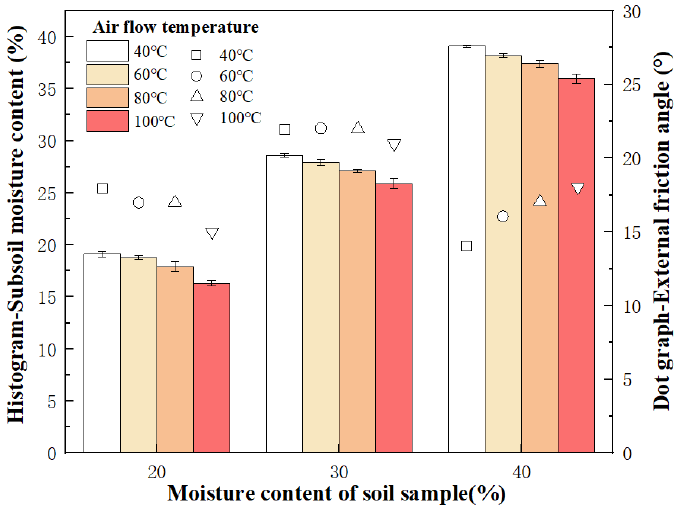
Figure 13. Effect of subsoil moisture content on the external friction angle.